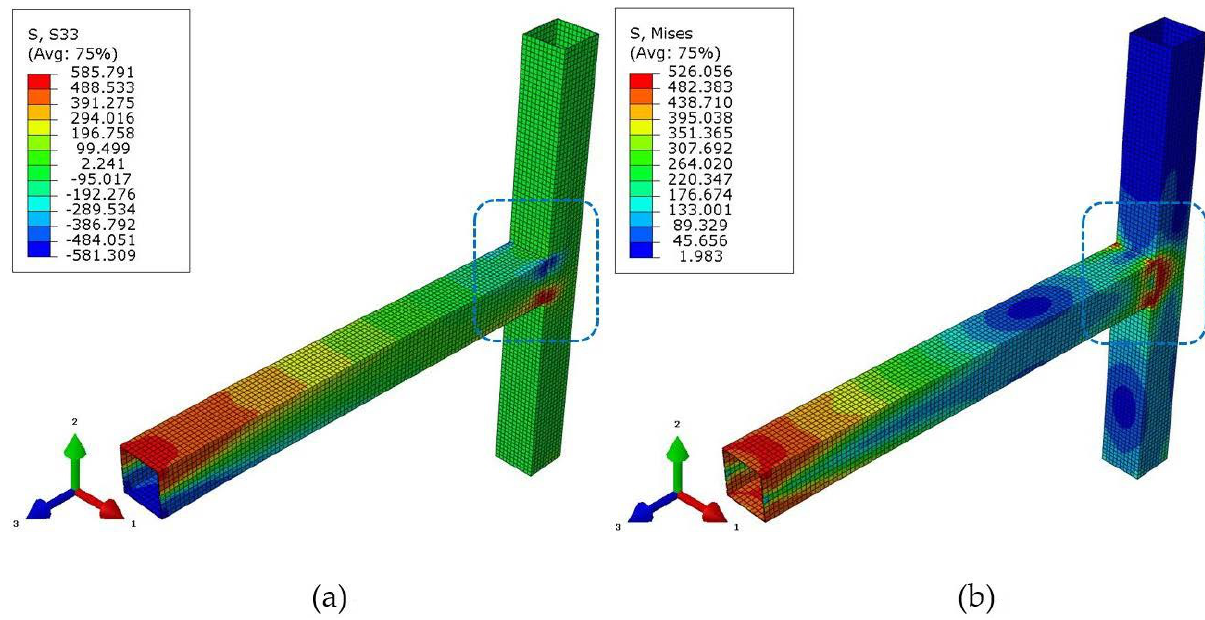
𝜎𝜎 𝑧𝑧 = 585.8 MPa.